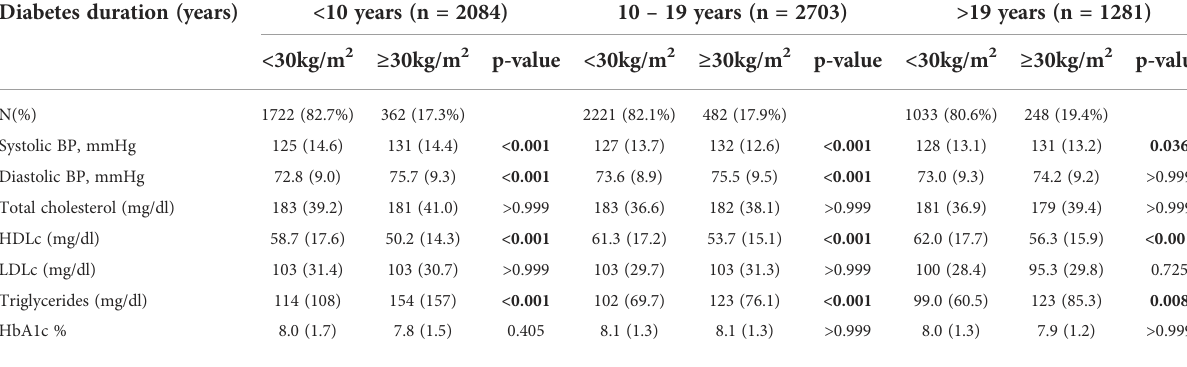
TABLE 3C Prevalence of obesity and clinical characteristics according to diabetes